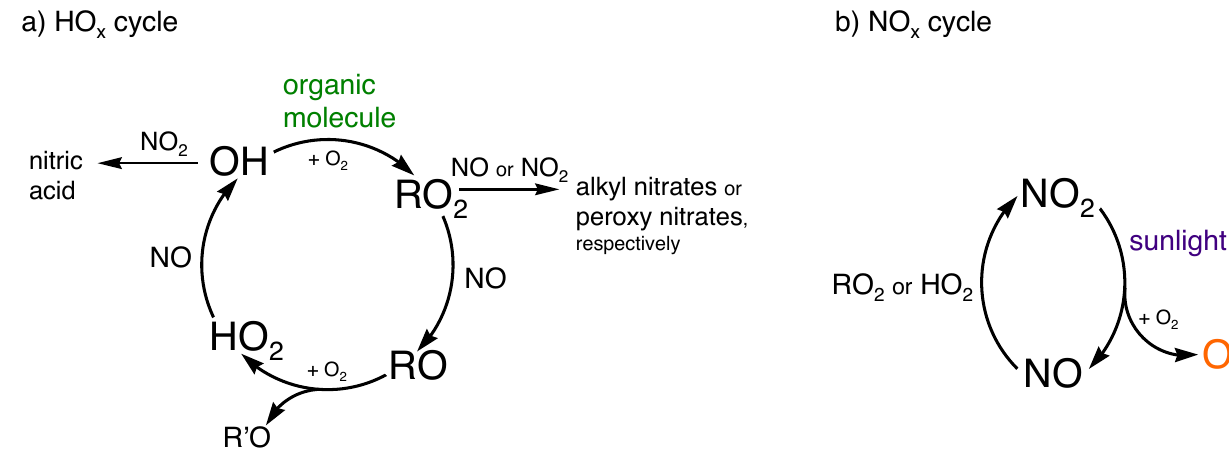
Fig. 1. Schematic of photochemical production of two new O 3 molecules from the oxidation of one generic organic molecule at the overlap of the HO x (a) and NO x (b) catalytic cycles. Only the NO x termination channels are shown. HO x chain terminations are reactions among peroxy radicals and OH. Figure 1. Schematic of photochemical production of two new O one generic organic molecule at the overlap of the HO the NO termination channels are shown. HO x radicals and OH. 6